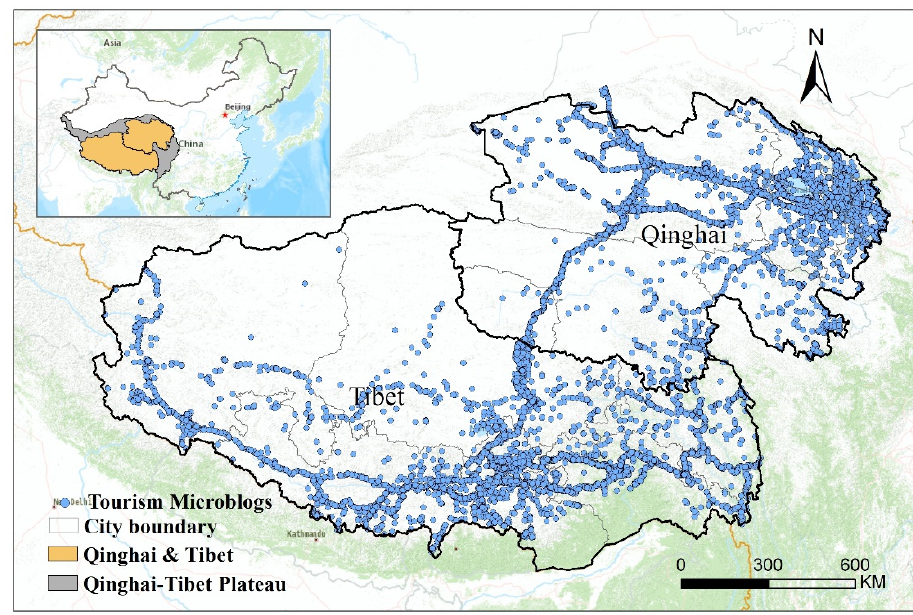
Figure 1. Study area and spatial distribution of tourism microblogs in 2017.